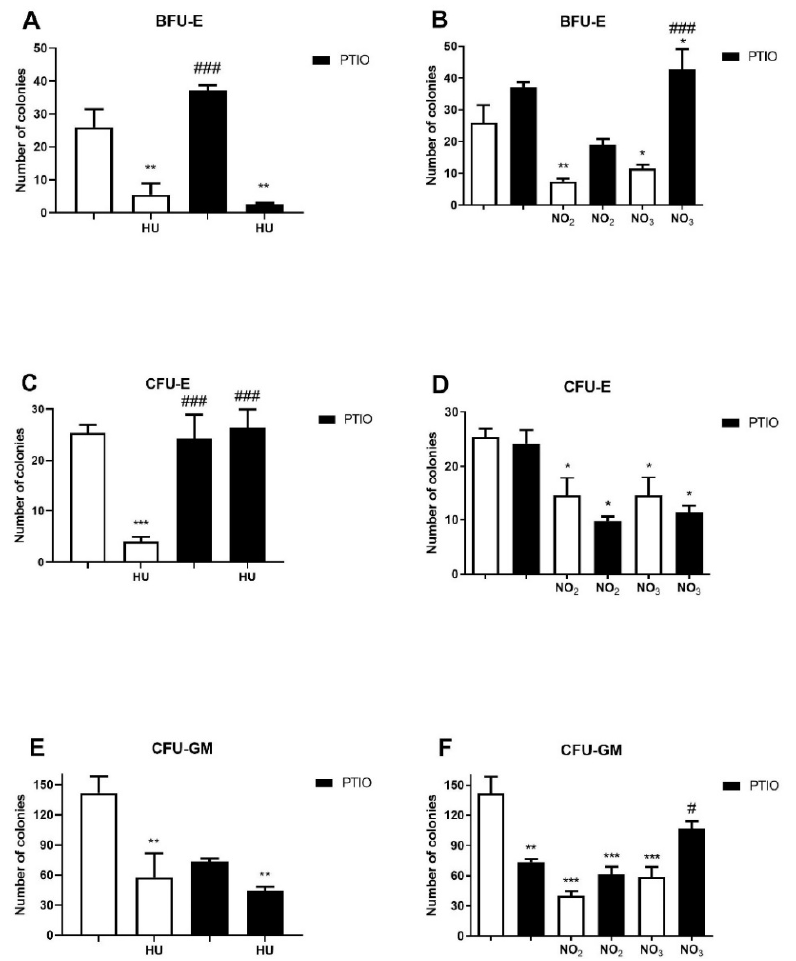
Figure 3. Myeloid progenitor growth of mouse bone marrow origin. Number of ex vivo BFU-E ( A , B ), CFU-E ( C , D ), and CFU-GM ( E , F ) colonies of mice treated with hydroxyurea (HU) ( A , C , E ), sodium nitrite (NO 2 ), and sodium nitrate (NO 3 ) ( B , D , F ) with or without PTIO. Values are mean ± SEM ( n = 10). * p < 0.05, ** p < 0.01 and *** p < 0.001 vs. non-treated mice (Control); # p < 0.05, and ### p < 0.001 vs. HU ( A , C ) or NO 3 ( B , F ) treated only.